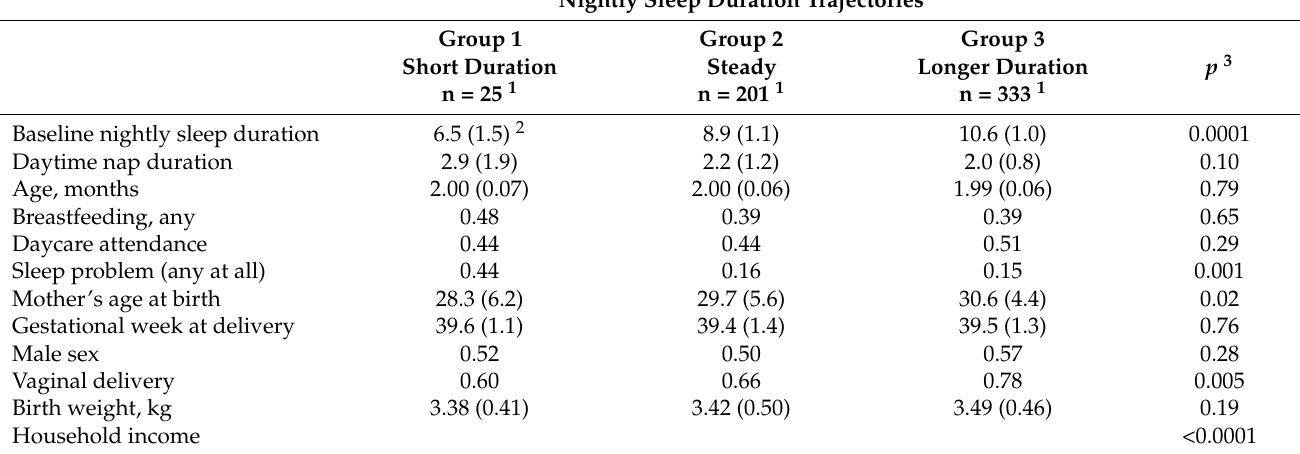
Table 1. Summary of sociodemographic and household characteristics according to trajectories of nightly sleep duration over childhood; 559 children enrolled in Center for Oral Health Research in Appalachia Cohort 2 between 2012 and 2018, with sleep data from age 2 years to age 5.5 years.